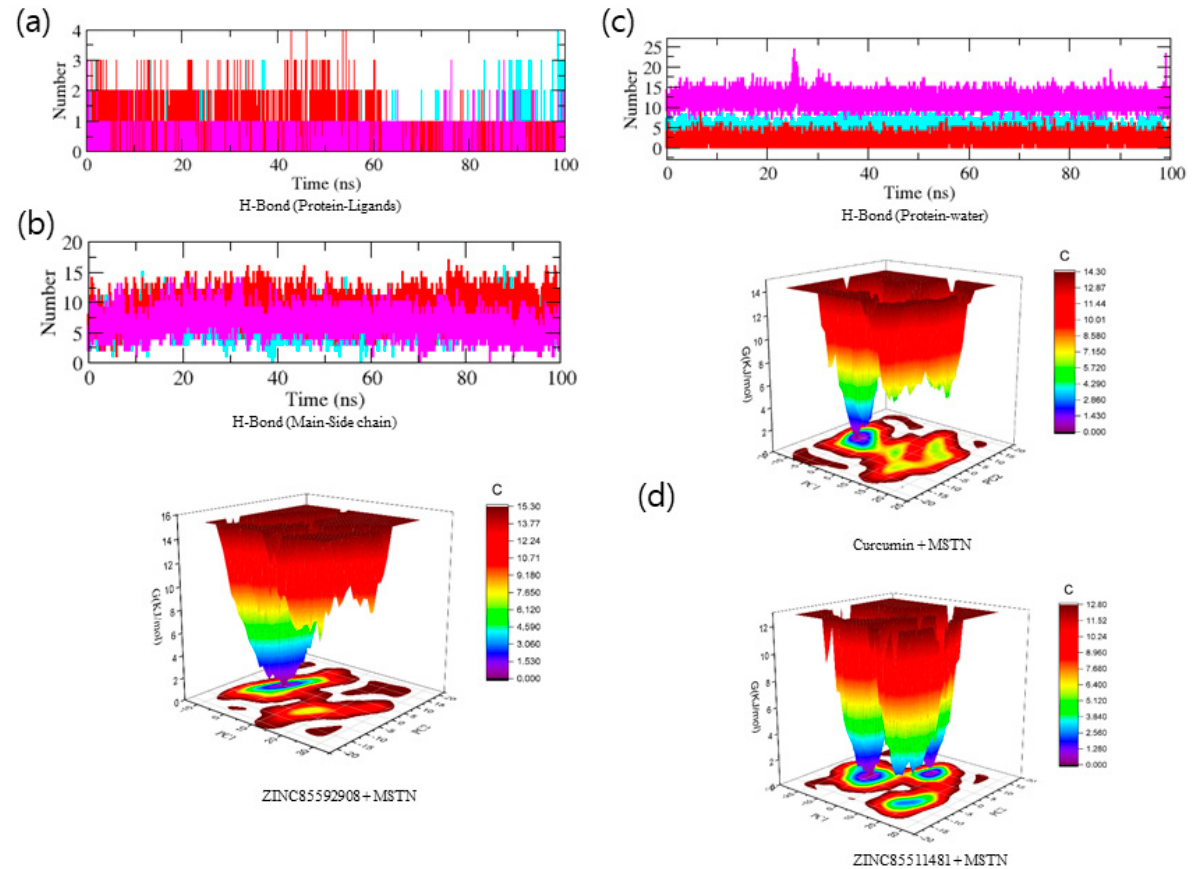
Figure 5. ( a – c ) Hydrogen bonding analysis between the MSTN protein and natural compounds, ( d ) GFE landscape plot for complexes.